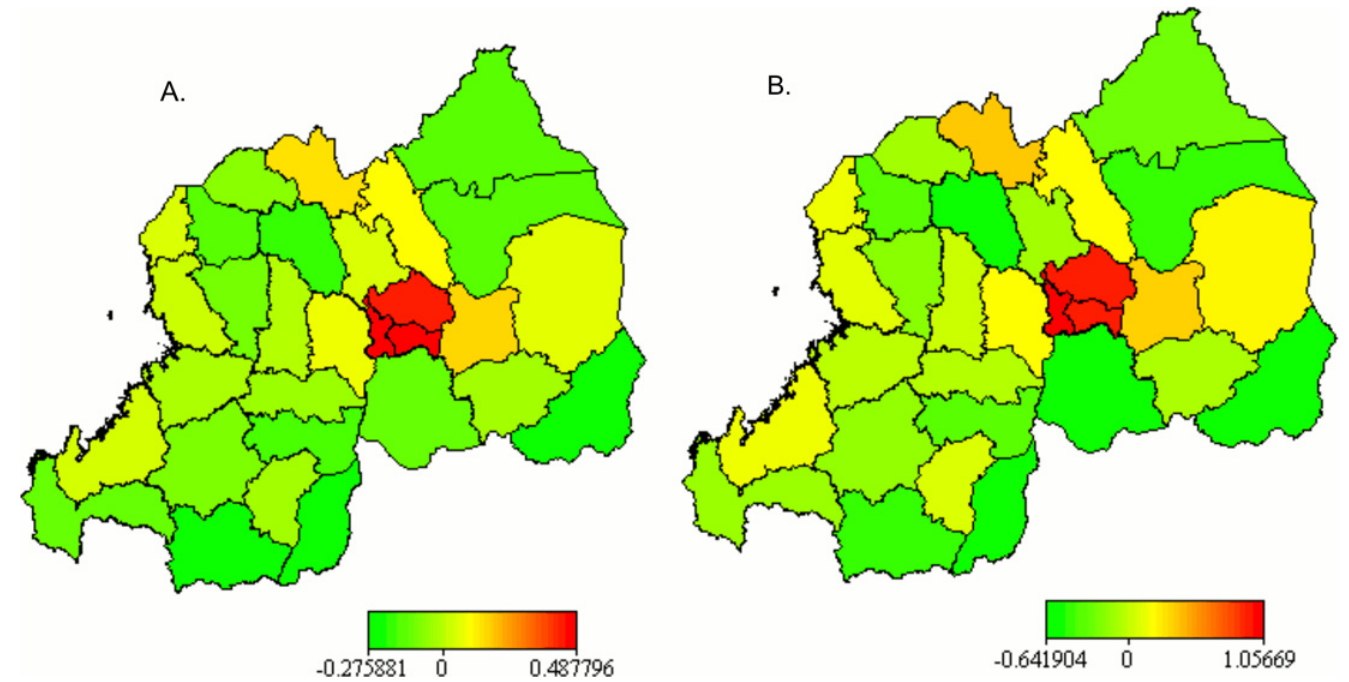
Fig 2. Posterior mean of the unadjusted structured (A) and total (B) spatial effects.